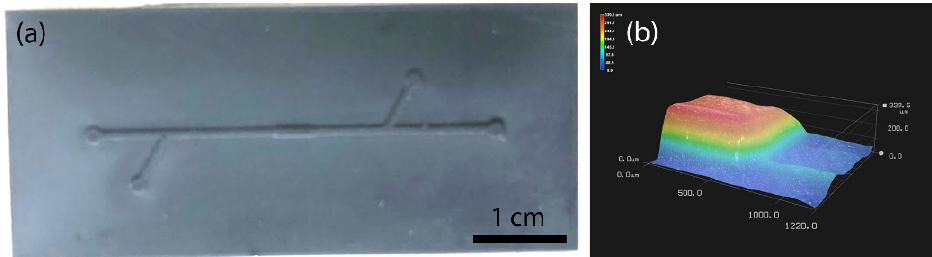
Figure 12. Casting mold fabricated out of black resin with the Form 2. ( a ) Casting mold and ( b ) 3D picture of the sieve taken from the casting mold at the transition of the lower to the higher channel structure.